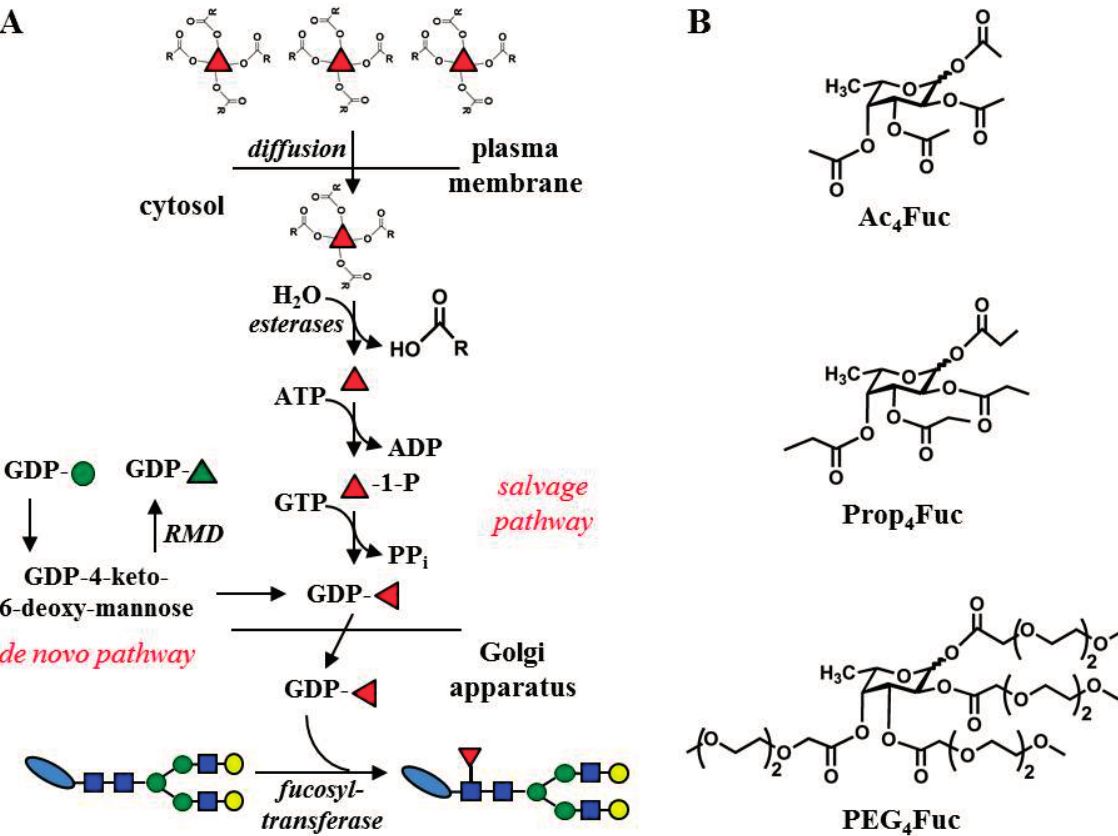
Figure 1: Schematic outline of the experimental approach used in this study ( A ). Biosynthesis of L-fucose (red triangle) occurs mainly via de novo synthesis and, to a minor extent, through the salvage pathway that is exploited here in the course of metabolic glycoengineering; Acyl moieties (shown in B ) are introduced to fucose to facilitate cellular uptake across the plasma membrane and are thought to be cleaved intracellularly by cytosolic esterases. Emanating from GDP-mannose (green circle), the de novo pathway can be blocked by enzymatic conversion of the intermediate GDP-4-keto-6-deoxymannose into a dead-end product (GDP-rhamnose, green triangle) by GDP-6-deoxy-D-lyxo-4-hexulose reductase (RMD) as previously shown in [22]. Other monosaccharide symbols are explained in Section